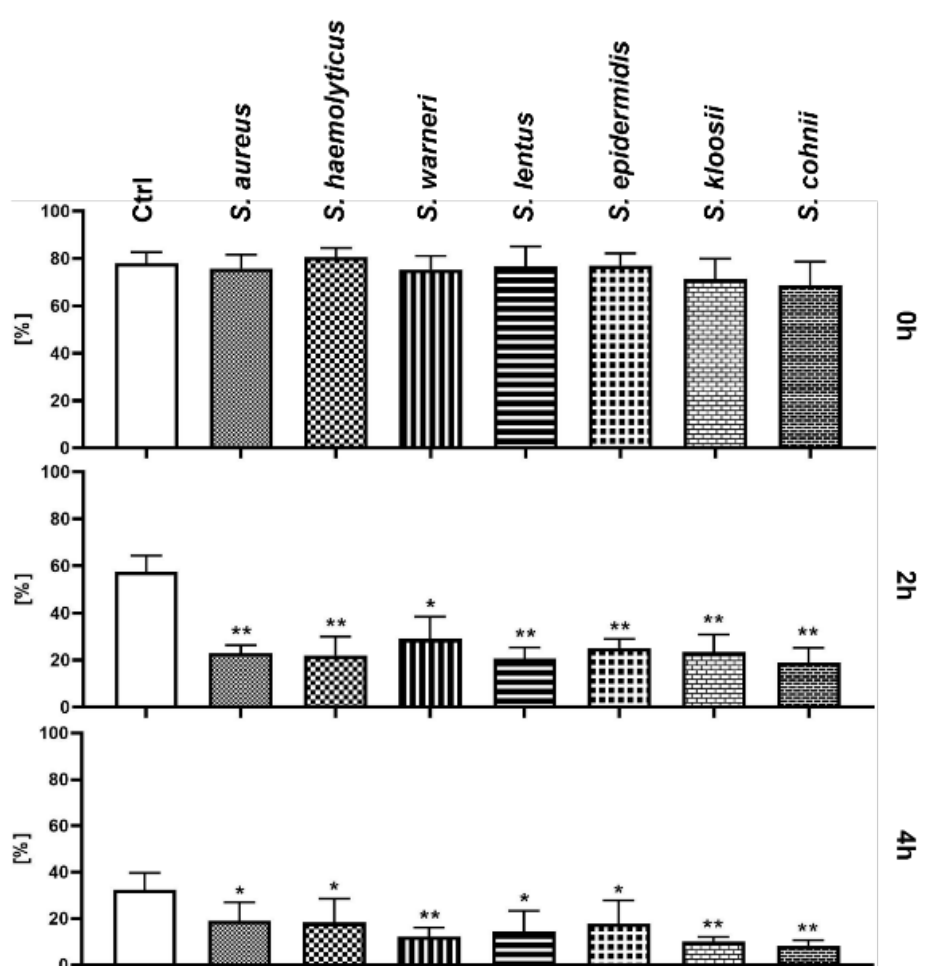
Figure 1. Changes in sperm motility during the 4 h bacteria/sperm co-incubation in vitro at 37 °C. Each group treated with Staphylococcus species was compared with the Ctrl group with no added bacteria. Each bar represents the mean percentage of motile sperm cells (≥5 µm/s) ± S.E.M. Five individual experiments were performed to obtain these data. The level of statistical significance was set at * p < 0.05; ** p < 0.01.